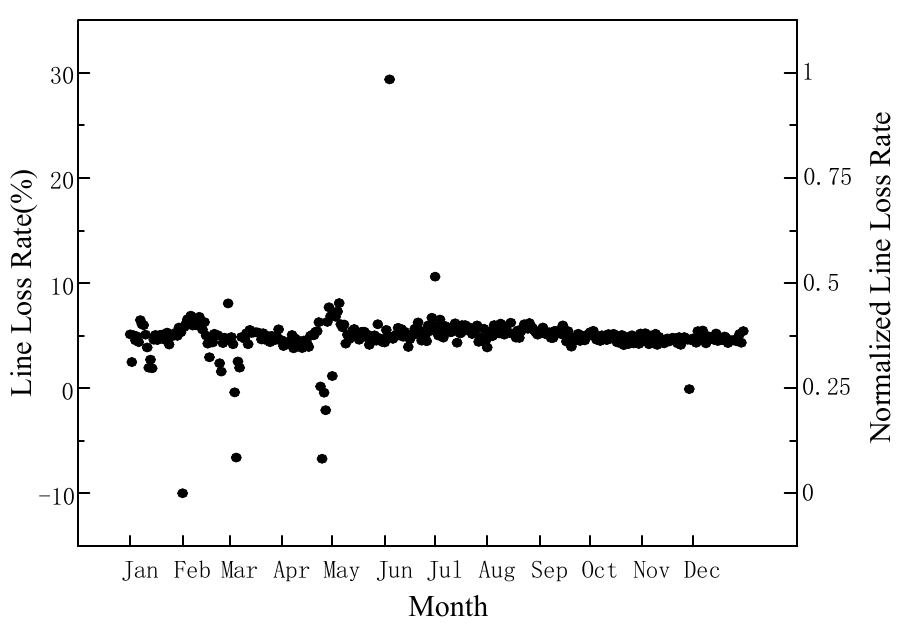
Figure 4. Distribution of historical line loss rate of data source YP.